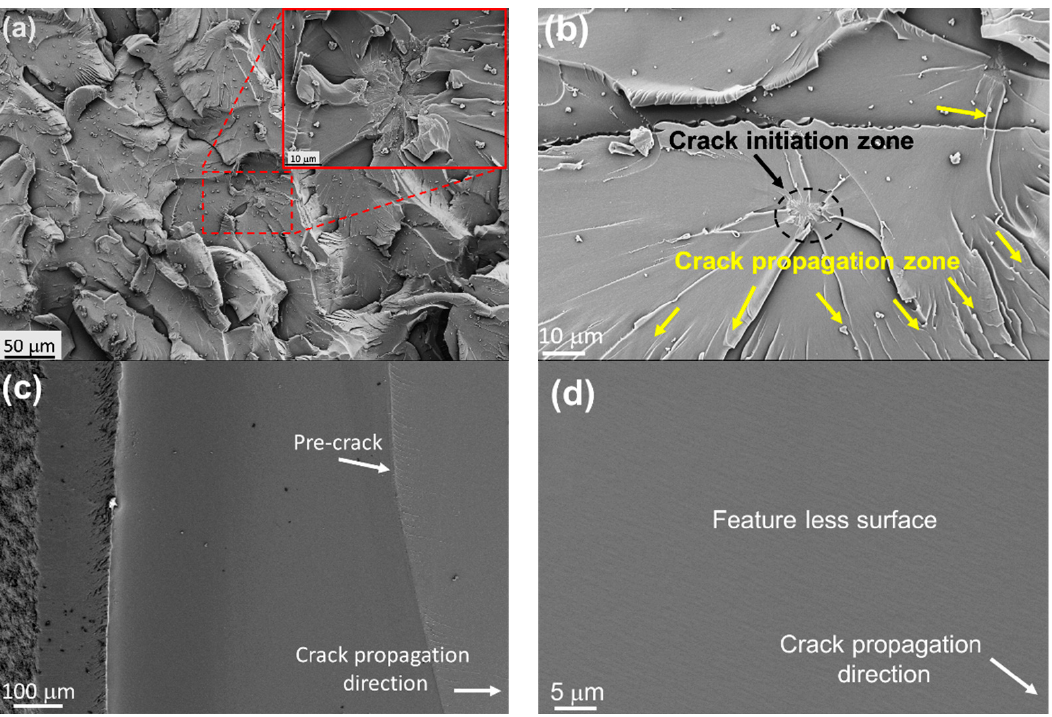
Figure 7. High Magnification SEM fractographs of representative MEP ( a , b ) tensile test specimen fracture surfaces and ( c , d ) compact tension specimen fracture surfaces, at room temperature.